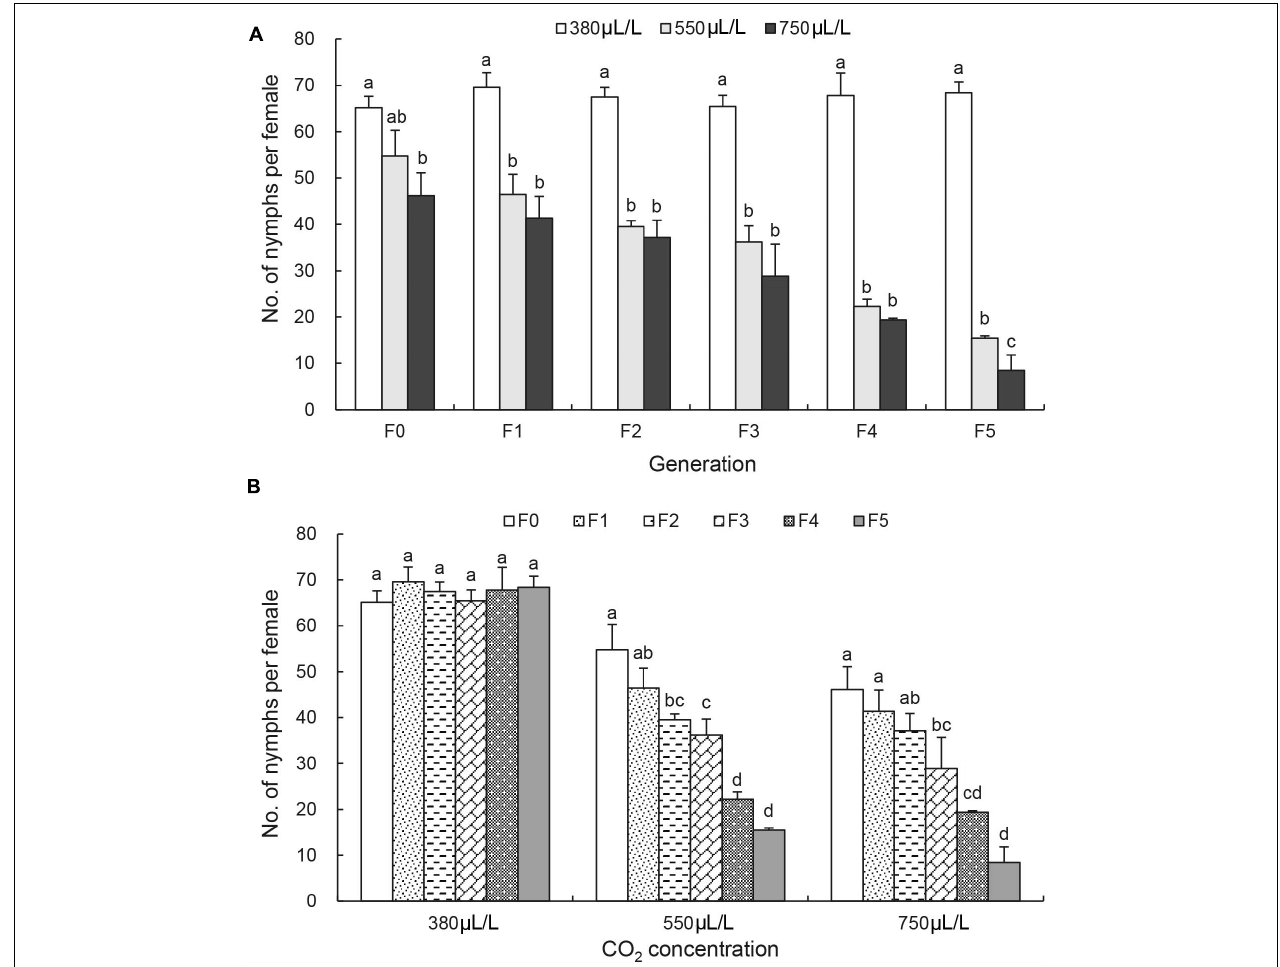
FIGURE 3 | Effects of CO 2 and generations on the female fecundity of Acyrthosiphon pisum . (A) Comparison of the effect of CO 2 levels (380, 550, and 750 µ L/L) at each of six generations (F 0 –F 5 ). (B) Comparison of the effect of generations under each of CO 2 levels (380 µ L/L, elevated 550 and 750 µ L/L). Different lowercase letters indicate significant differences between CO 2 levels at each generation (A) and between generations at each CO 2 level (B) as determined by one-way ANOVA Tukey’s HSD test at p <